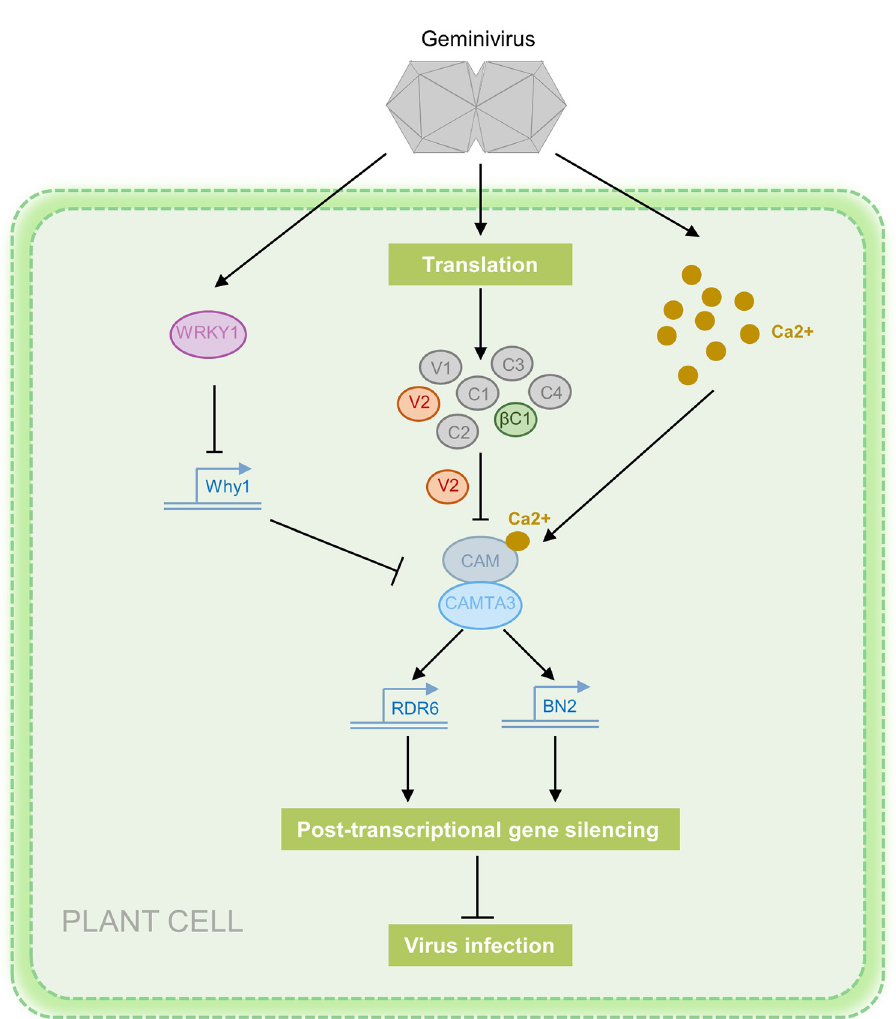
Fig 8. A working model summarizing the role of NbWRKY1 in regulation of geminivirus infection. Geminivirus infection could activate the Ca2+ pool and trigger Ca2+ ! CaMs ! CAMTA3 ! BN2/RDR6 signaling cascade to prime antiviral RNAi defense. To counteract host defense, geminivirus-encoded V2 disrupts the CaM-CaMTA3 interaction to suppress RNA silencing [26]. To counter-counter defense, NbWRKY1 is upregulated upon geminivirus infection. NbWRKY1 represses the expression of NbWhy1, a negative regulator of RNAi that can interfere with the CaM3-CAMTA3, leading to enhanced plant defense against geminivirus infection. Arrows represents activation while the “T” sign indicates attenuation or